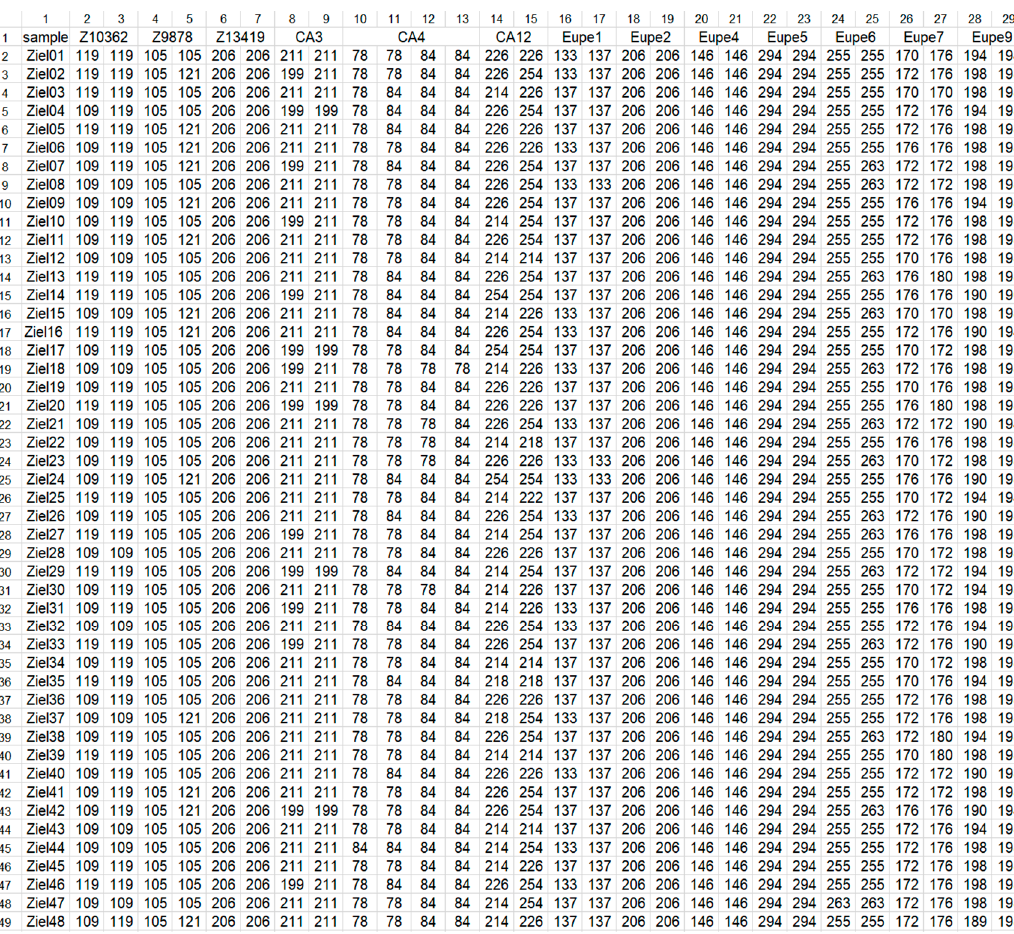
Figure 1. Genetic profiles of lake minnow individuals from Zielonka (ZI) population as an example of input file to Genassemblage 2.2. Column 1, fish ID (samples); columns 2–29, names of microsat- ellite markers (line 1) and their alleles (lines